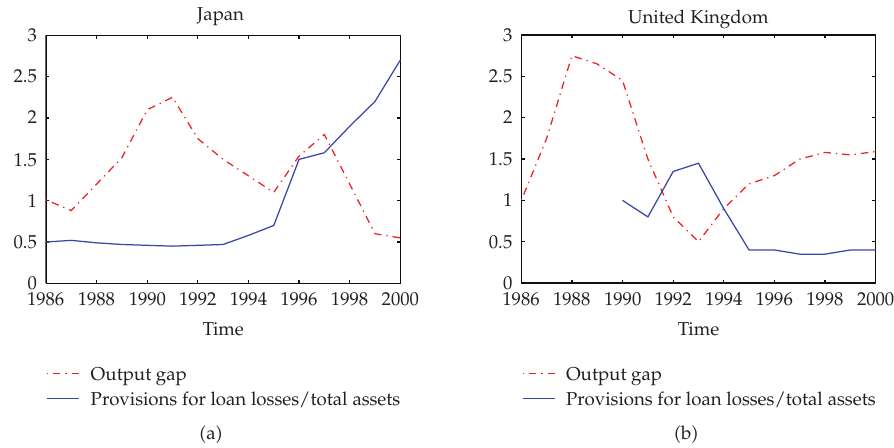
Figure 4: Output gap versus provisions for loan losses-to-total assets ratio for Japan and United Kingdom (cid:2) 1986–2000 (cid:3)